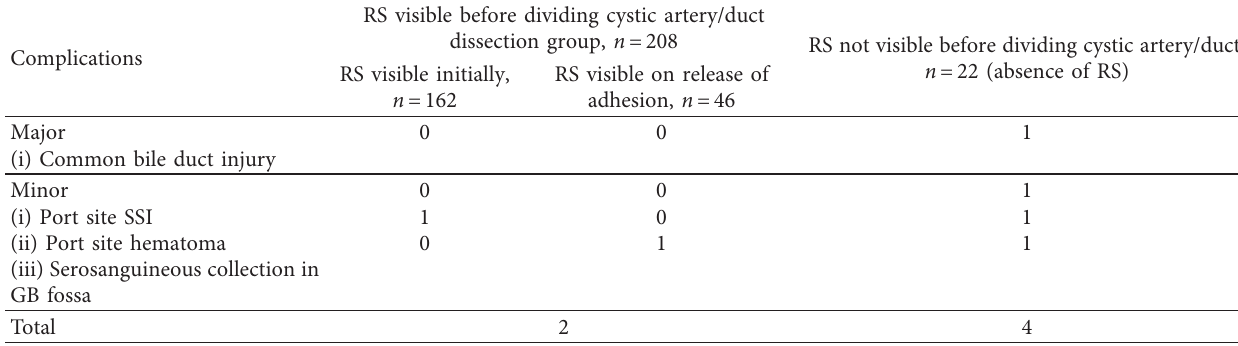
Table 2: Intra/postoperative complications and